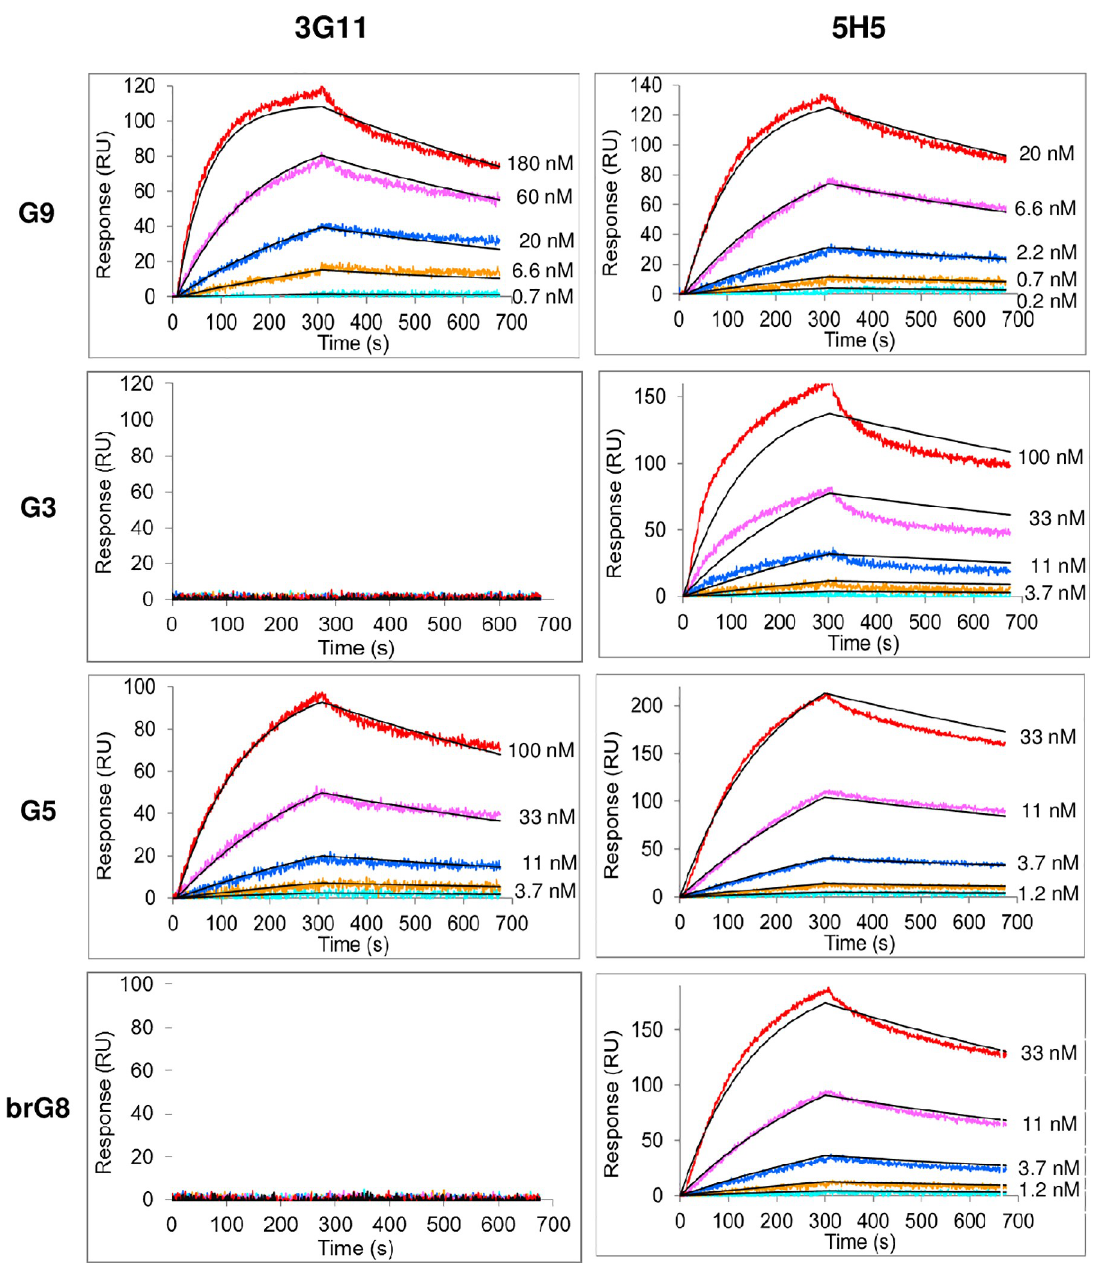
Fig 3. Binding of mAbs 3G11and 5H5 with biotinylated oligosaccharide ligands assayed by SPR. Serial three-fold dilutions of mAb 3G11 (left side) and mAb 5H5 (right side) were used as analytes. Experimental data are shown as color lines; fitted data are depicted as black curves; fitted traces are depicted as smooth black lines. Starting antibody concentrations were determined in scouting experiments. The antibodies demonstrated different carbohydrate specificity profiles. 5H5 was less selec- tive and recognized all tested ligands except mono- ( G1 ), diglucoside ( G2 ) and branched tri- glucoside ( brG3 ). 3G11 recognized all linear oligoglucosides longer than a pentamer ( G5 , G7 , G9 , G11 ), but it did not recognize branched oligoglucosides brG6-I, brG6-II, brG8 , showing differences between the affinities of both mAbs. The mAbs did not recognize α -(1 ! 3)-linked